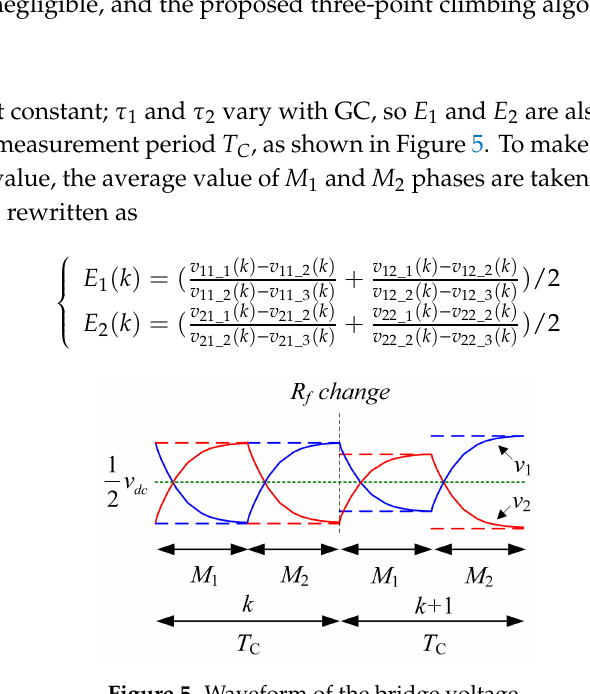
Figure 5. Waveform of the bridge